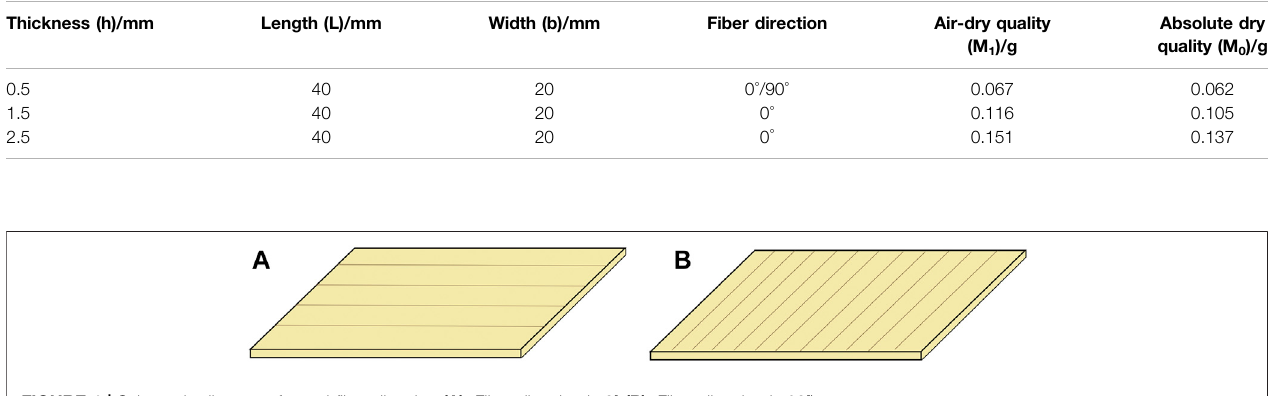
FIGURE 1 | Schematic diagram of wood fi ber direction (A) . Fiber direction is 0 ° (B) . Fiber direction is 90 ° ).